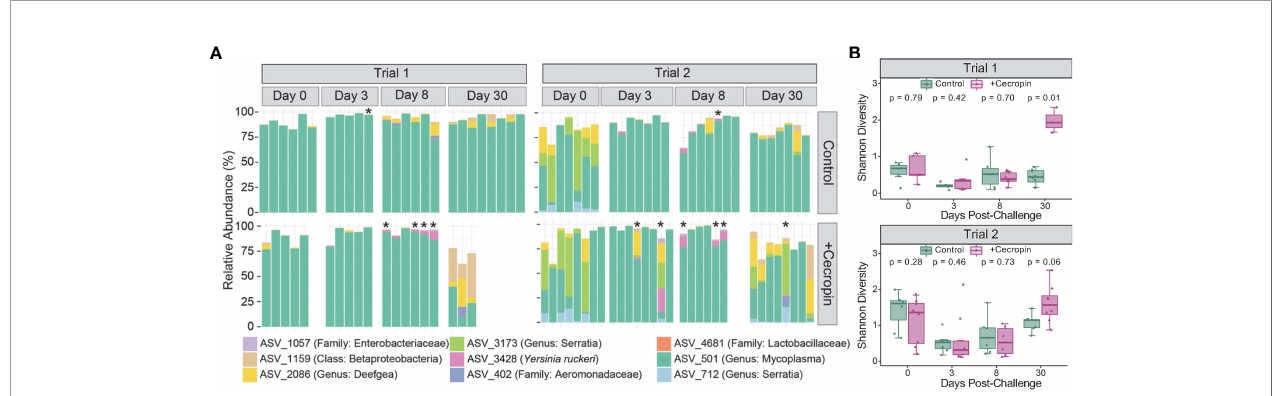
FIGURE 4 | Microbiome comparison between fi sh challenged with Y. ruckeri fed either control or +cecropin diet. (A) Relative abundance of the 9 most prevalent taxa are shown for individual fi sh sampled before challenge (day 0) and post challenge (days 3, 8, and 30). Taxonomic assignments represent the most speci fi c level of resolution assigned by Greengenes, with the exception of ASV_3428 which was identi fi ed by multiple methods (see text for details). Fish marked with an * had high absolute abundance of Y. ruckeri as measured by qPCR (detection after 25 or fewer cycles, corresponding to ~1.5x10 4 bacteria/20 mg of intestinal tissue). Baseline microbiomes at the start of trial 1 were markedly different from those at the start of trial 2. (B) Alpha diversity as measured by Shannon index for trial 1 and trial 2; p-values are for comparisons of diet groups at each timepoint, as assessed by Wilcoxon signed rank test with correction for multiple